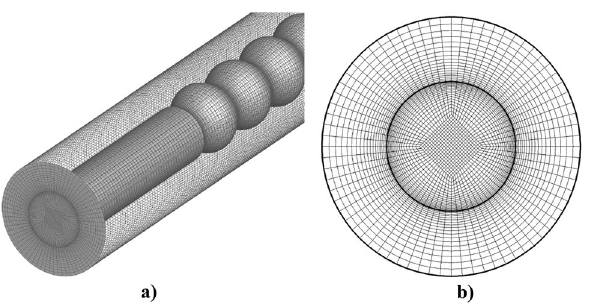
Figure 3. Applied grids ( a ) 3-D view, ( b ) cross section.